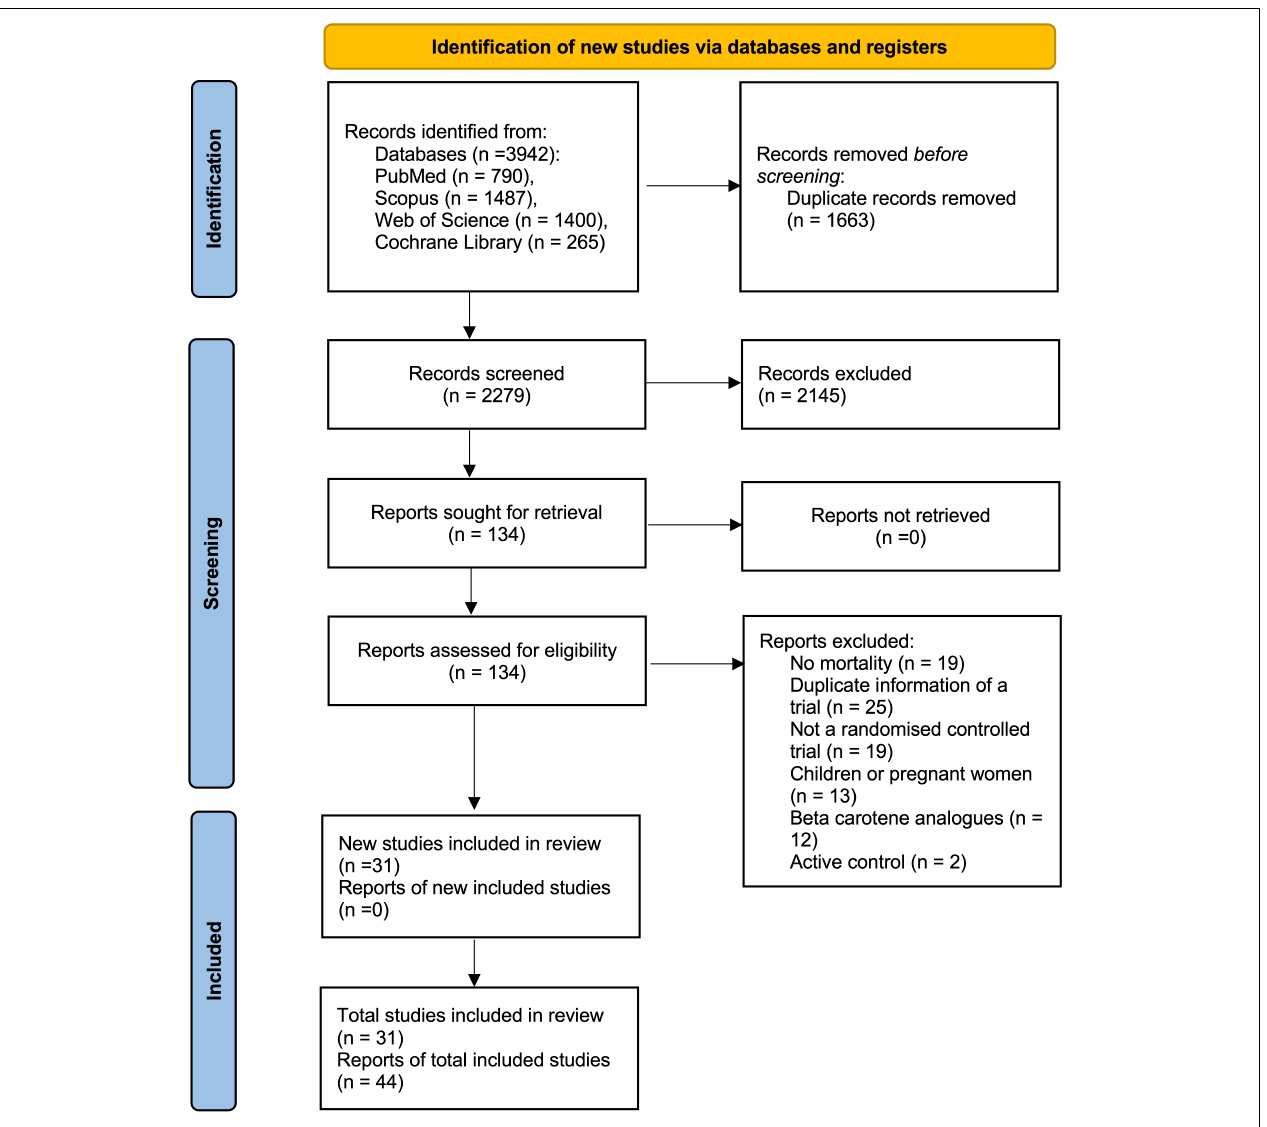
FIGURE 1 | Search strategy and final included and excluded studies by the PRISMA